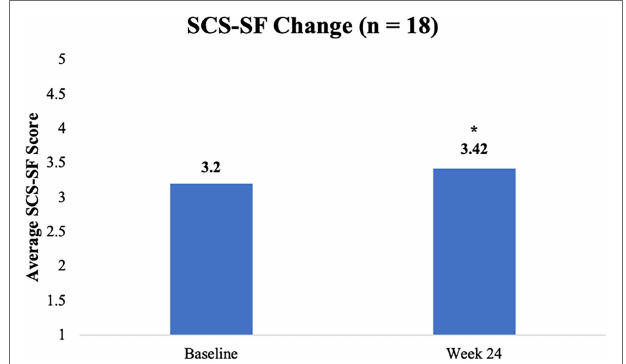
FIGURE 3 | Change in SCS-SF scores from baseline to week 24. * p < 0.05